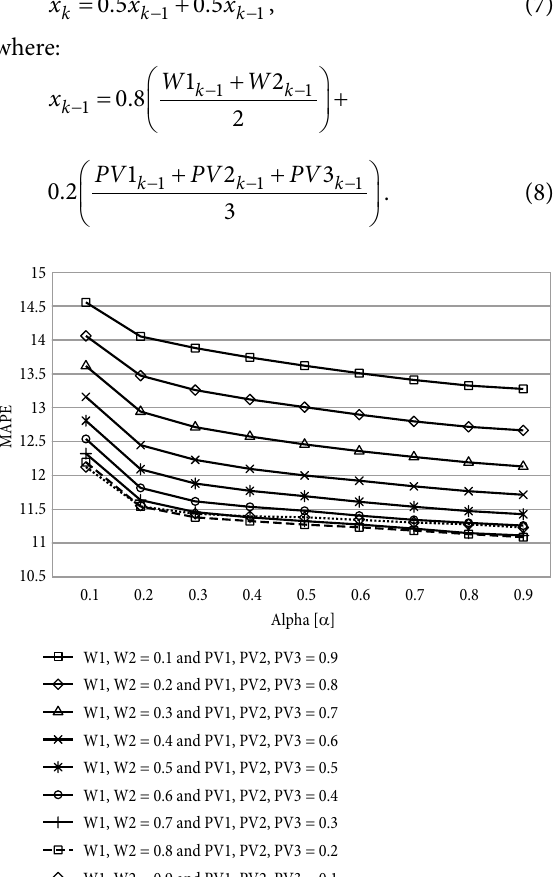
Fig. 1. MAPE for varying weights for inputs and varying alpha a